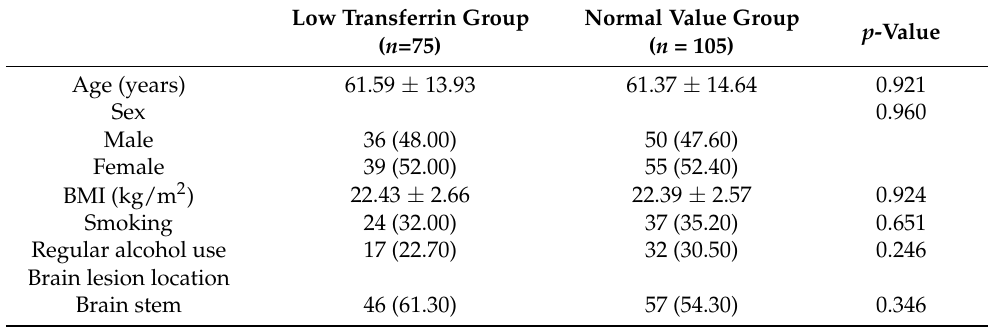
Table 2. Comparison of characteristics between the low transferrin group and normal value